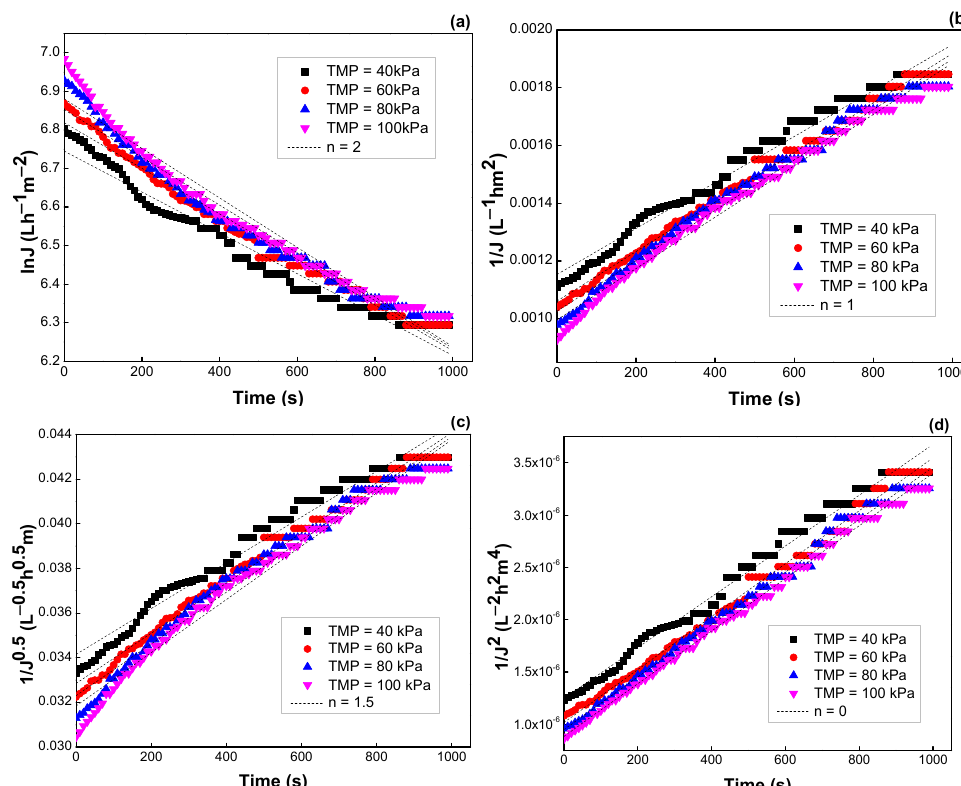
Figure 11. Effect of TMP on the flux predicted by the Hermia model: ( a ) n = 2, ( b ) n = 1, ( c ) n = 1.5, and ( d ) n = 0 (see Table 3).